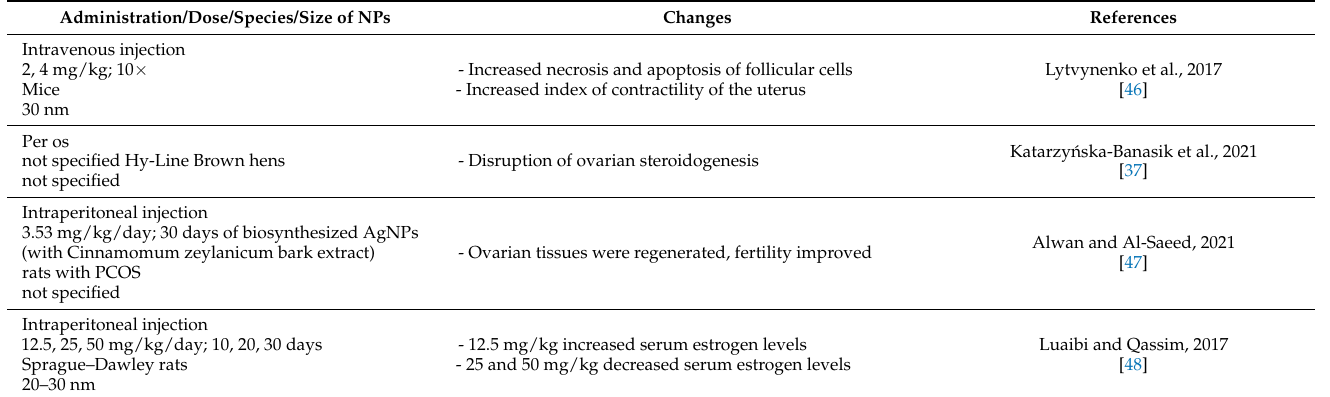
Table 2. Alterations in the female reproductive system caused by